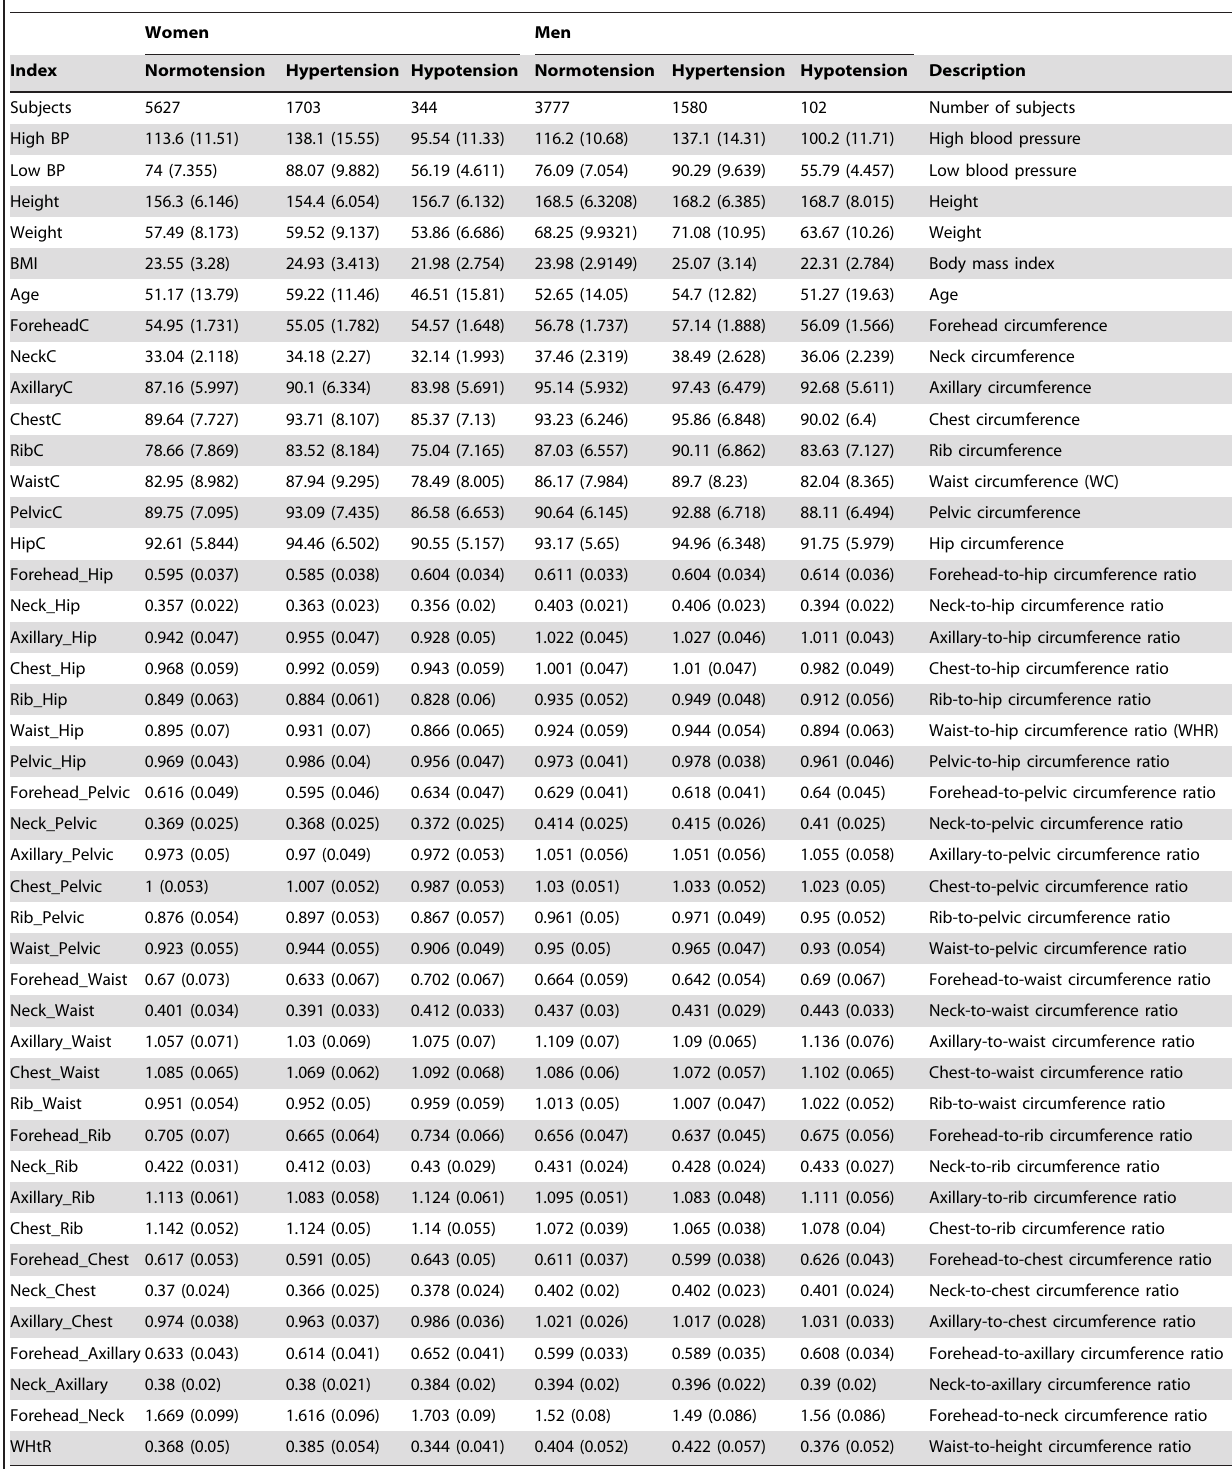
Table 1. Baseline characteristics and brief descriptions of the anthropometric indices used in this study.